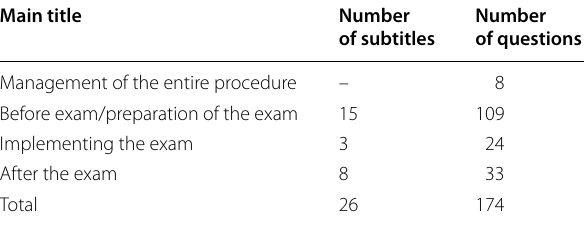
Table 5 Distribution of subtitles and questions according